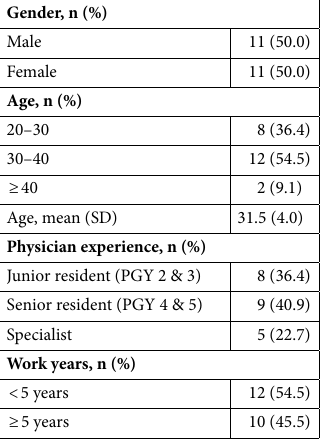
Table 1. Characteristics of the physician. Demographic characteristics of participants (n = 22). PGY post graduate year.